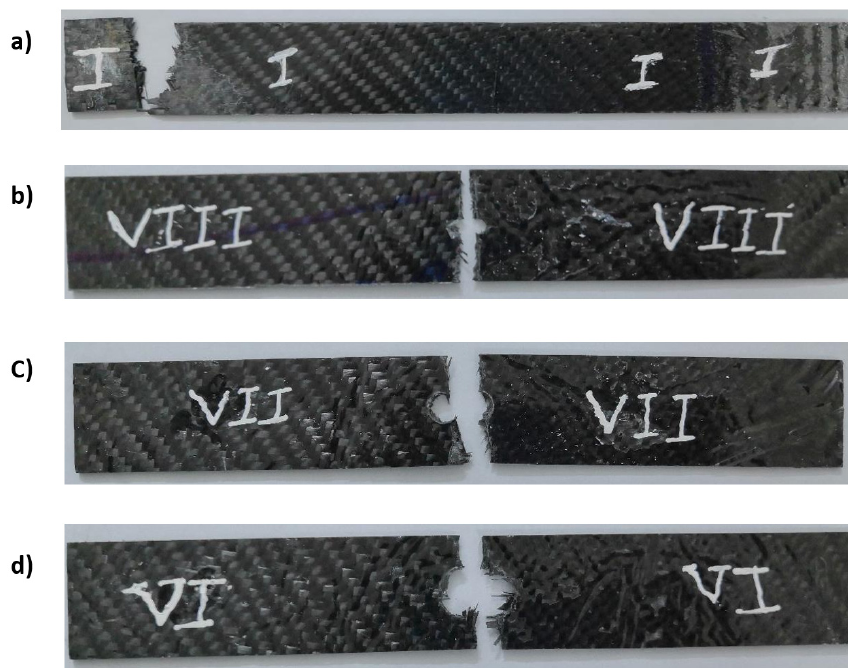
Figure 17. Failure modes in the relaxation test for CFRP with hole diameters ( a ) no notch, ( b ) 4 mm, ( c ) 8 mm, ( d ) 12 mm.